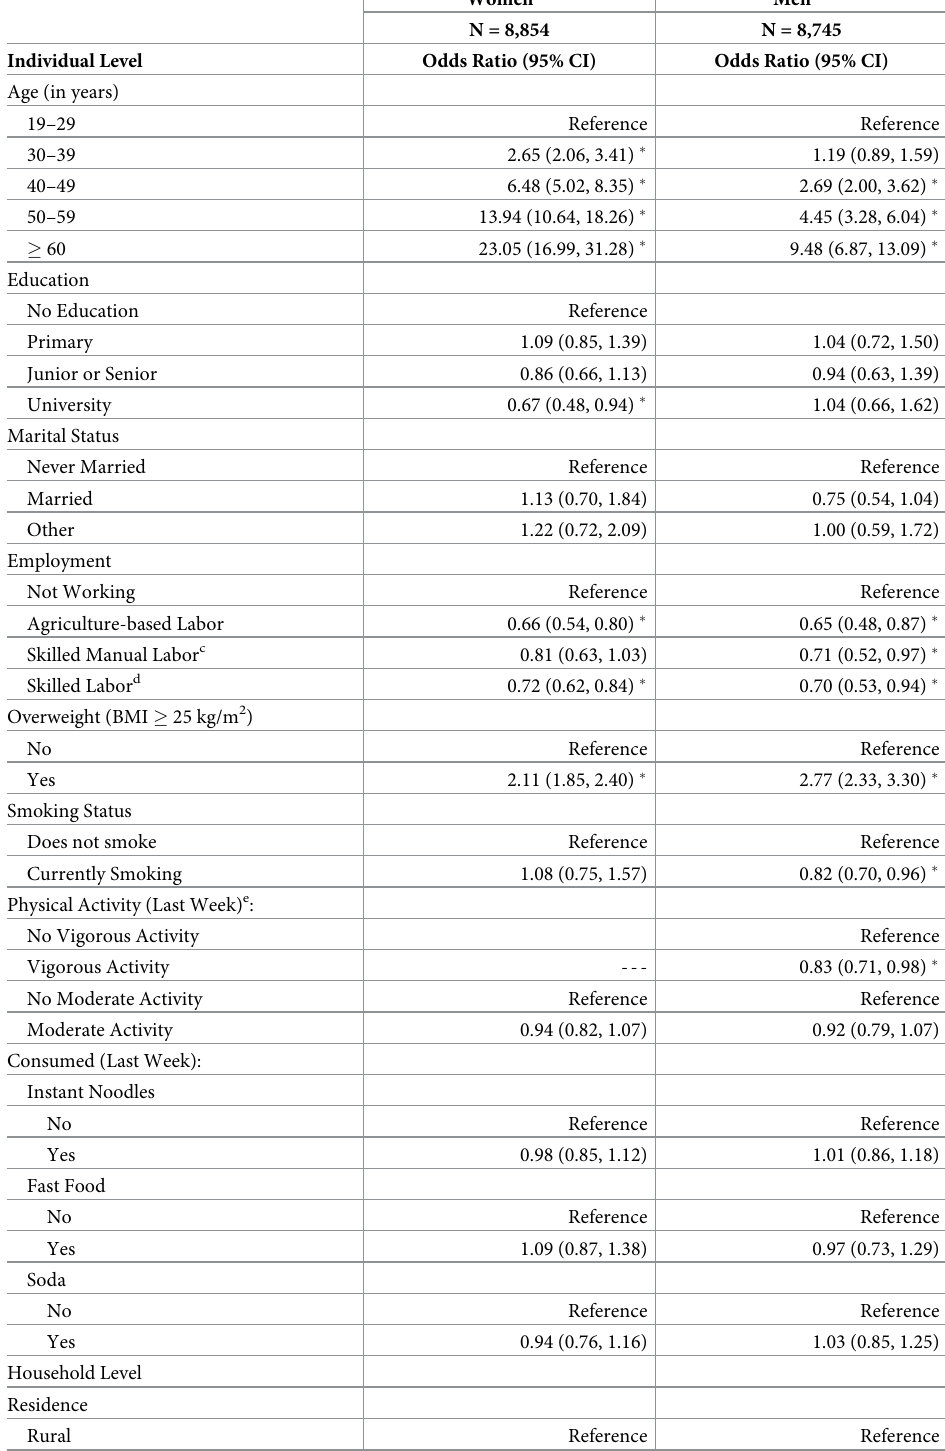
Table 2. Multivariable Logistic Regression Testing the association between selected characteristics and hyperten- sion among adults in Indonesia,